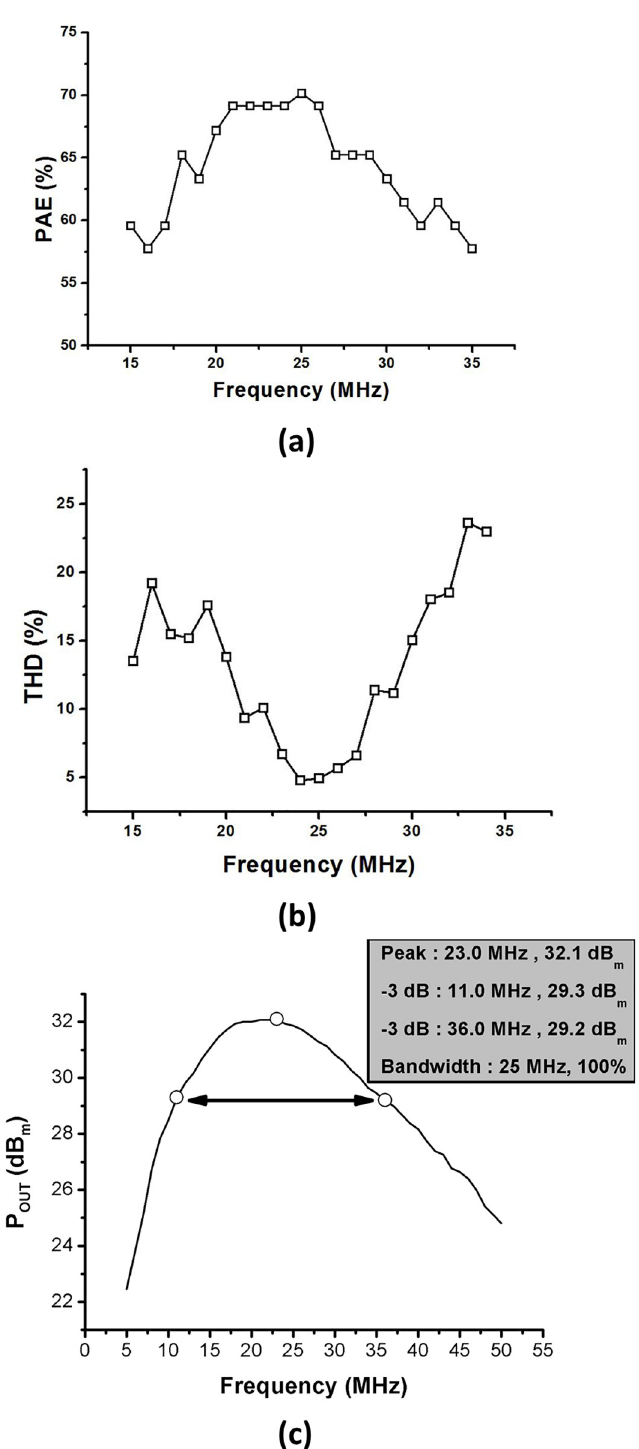
Fig 14. Curves showing variation of P OUT and calculated PAE and THD values obtained from high-efficiency and high-voltage class F amplifier with a 7.5 dBm input power according to frequency. (a) PAE vs. Frequency, (b) THD vs. Frequency, (c) P OUT vs.